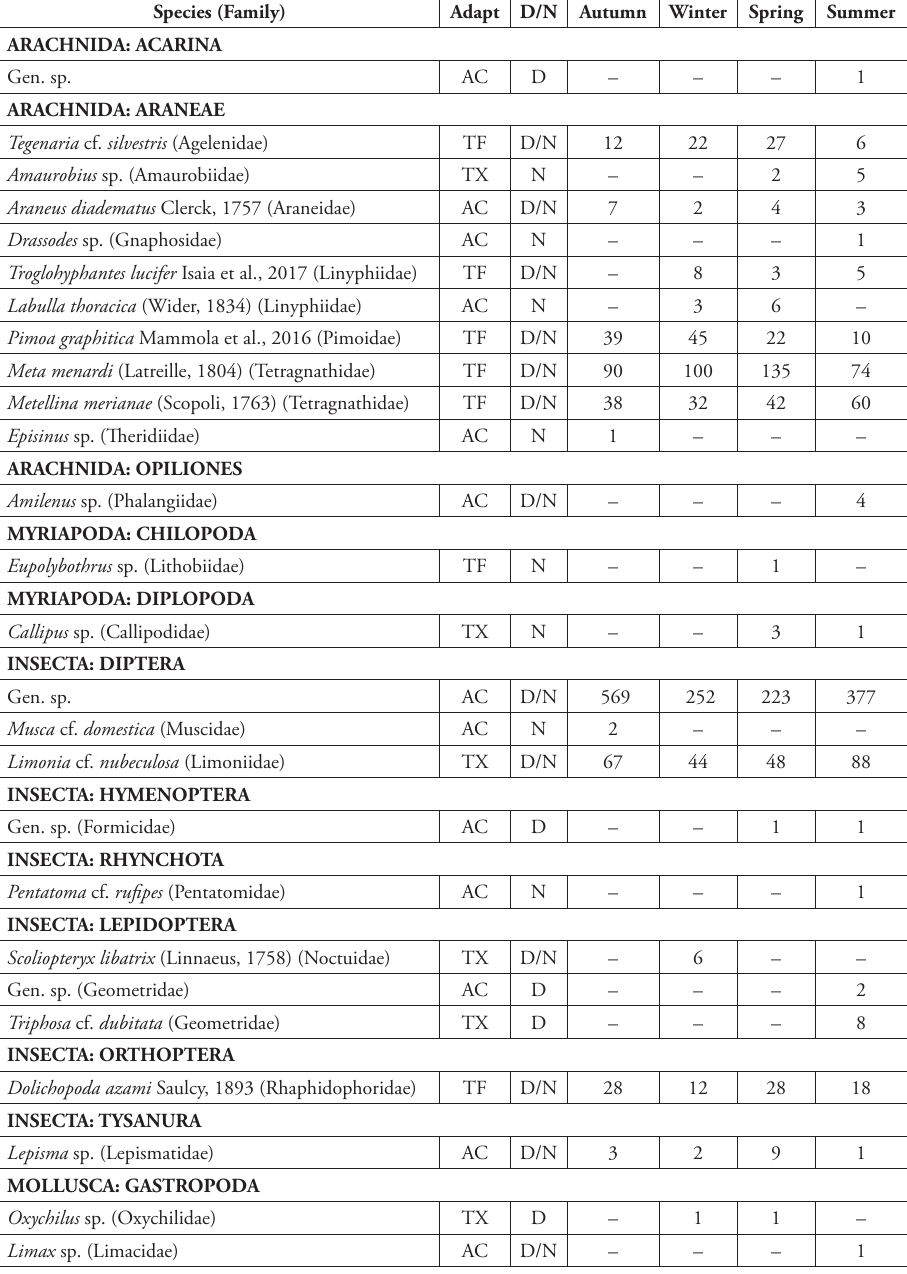
Table 1. Checklist of the taxa recorded within the study site. For each taxon we report the ecological clas- sification (Adapt; TF= Troglophile, TX= Trogloxene, AC= Accidental), the diurnal/nocturnal occurrence (D/N; D= day, N= night) and the seasonal